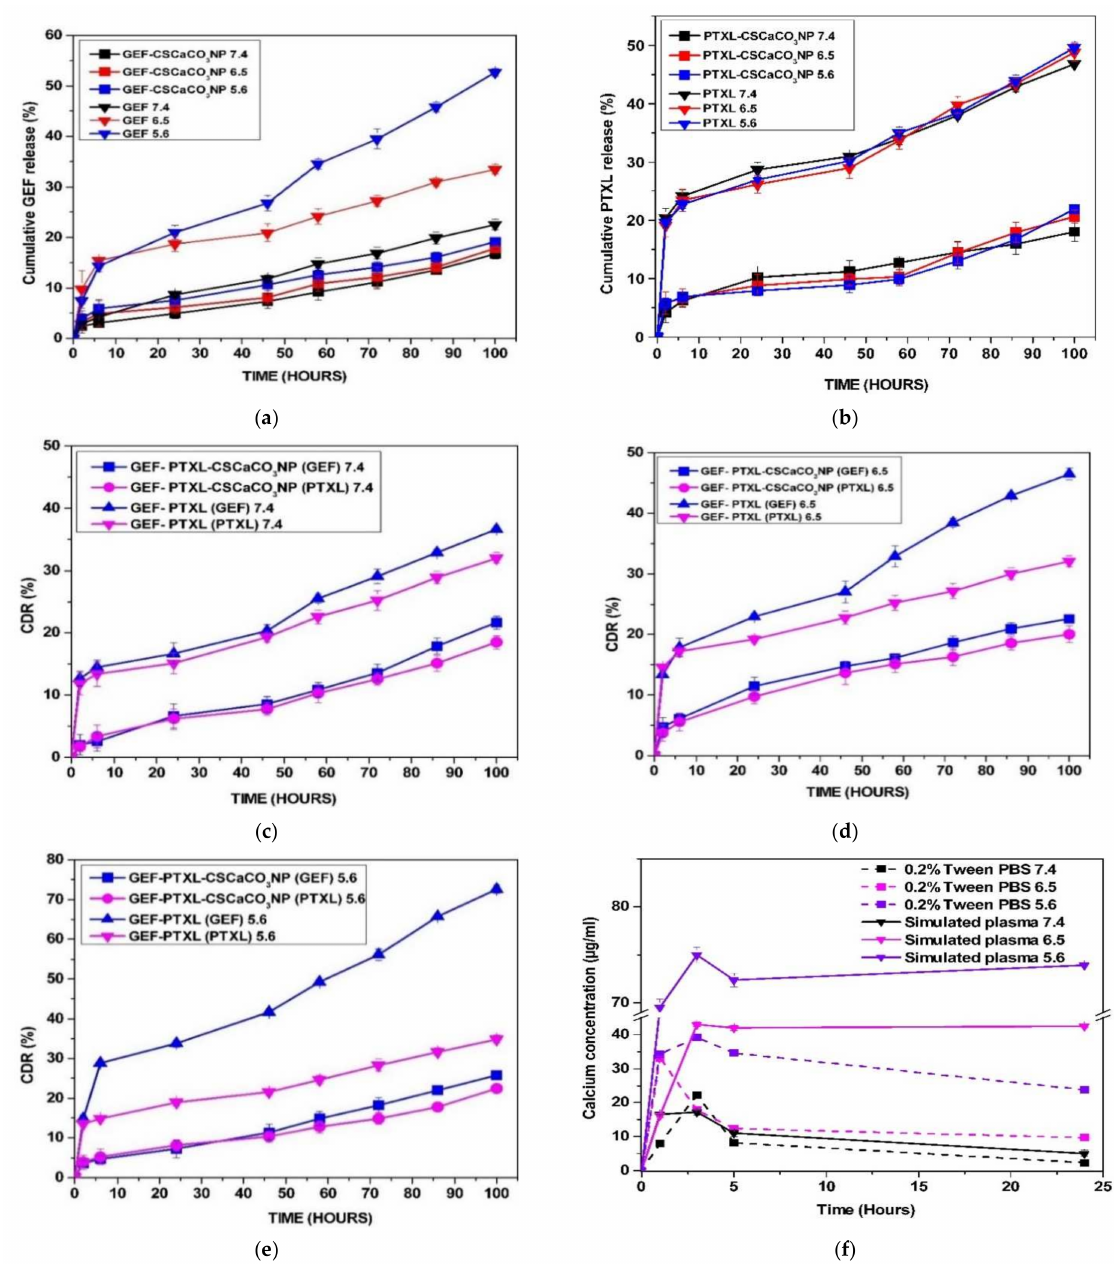
Figure 6. In vitro release of: ( a ) GEF from GEF-CSCaCO 3 NP in PBS with 0.2% ( v / v ) Tween 80 at pH of 5.6, 6.5, and 7.4; ( b ) PTXL from PTXL-CSCaCO 3 NP PBS with 0.2% ( v / v ) Tween 80 at pH 6.5, 5.6, and 7.4; ( c ) GEF and PTXL from GEF-PTXL-CaCO 3 NP in PBS with 0.2% ( v / v ) Tween 80 at pH of 7.4; ( d ) GEF and PTXL from GEF-PTXL-CaCO 3 NP in PBS with 0.2% ( v / v ) Tween 80 at pH of 6.5; ( e ) GEF and PTXL from GEF-PTXL-CaCO 3 NP in PBS with 0.2% ( v / v ) Tween 80 at pH of 5.6; and ( f ) Calcium concentrations released from CSCaCO 3 NP in PBS with 0.2% ( v / v ) Tween 80 and simulated plasma conditions at pH of 5.6, 6.5, and 7.4 (Break in y -axis: